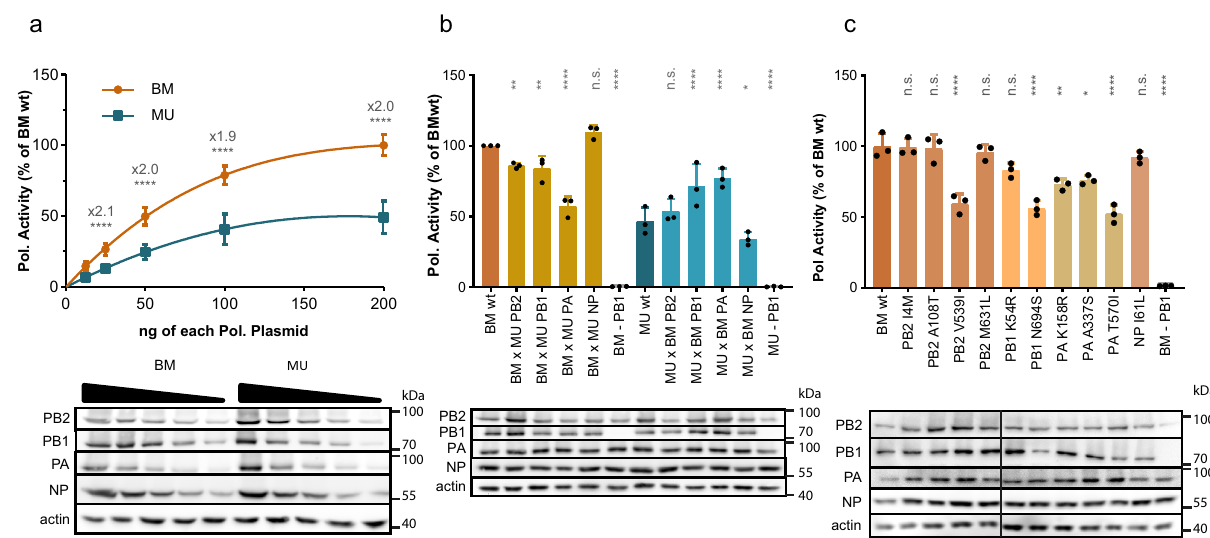
Fig. 2 In vitro activity of reconstituted BM and MU-162 polymerases by mini-genome reporter assay. a Dose response of transfected MU-162 (here referred to as MU) polymerase in comparison to BM activity, arbitrarily set to 100%. b Effect of whole segment swapping. Comparative analysis of BM and MU-162 polymerase complexes expressed as wild type (wt) or as reassorted 3 + 1 combinations. c Effect of single BM-to-MU-162 aa changes in the context of the BM polymerase. Each assay was conducted in n = 3 independent replicates with experimental triplicates. Values are means ± SD. Signi fi cance was determined by nested ANOVA. * P < 0.05; ** P < 0.01; **** P < 0.0001. All three lower panels depict the expression levels of polymerase subunits by immunoblot analyses. A representative result of n = 3 independent assays is shown. Source data are provided as a Source Data fi